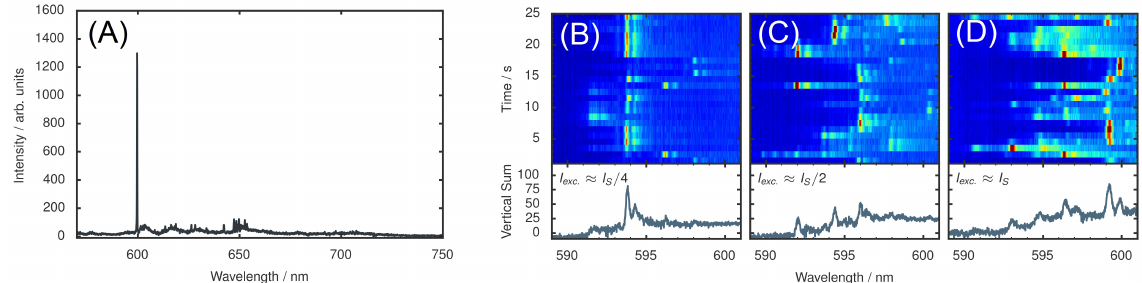
Figure 4: (A) PL spectrum that emits SPSs from the optical ZPL transition at 5 K. (B–D) Power-dependent spectral jumps of the ZPL of three different ZnO defect centers at excitation intensities. Reproduced with permission from Ref. [51]. PL: photoluminescence; SPSs: single- photon sources; ZPL: zero-phonon